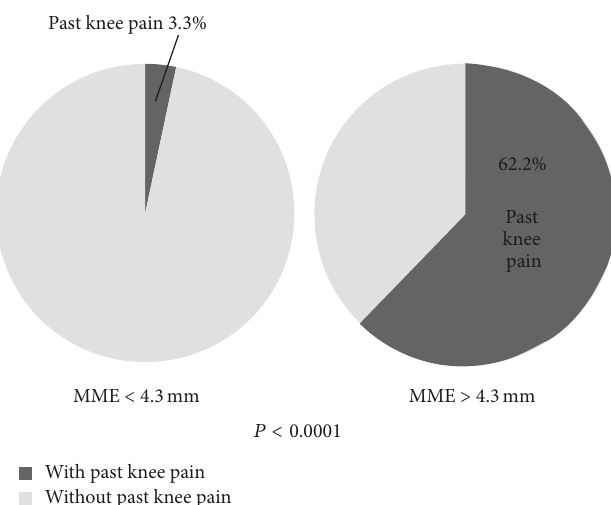
Figure 3: Rate of past knee pain in the N-group. In the N-group, the rate of knees with pain in the past among the knees with MME greater than 4.3 mm is significantly larger than that of knees with MME less than 4.3 mm.